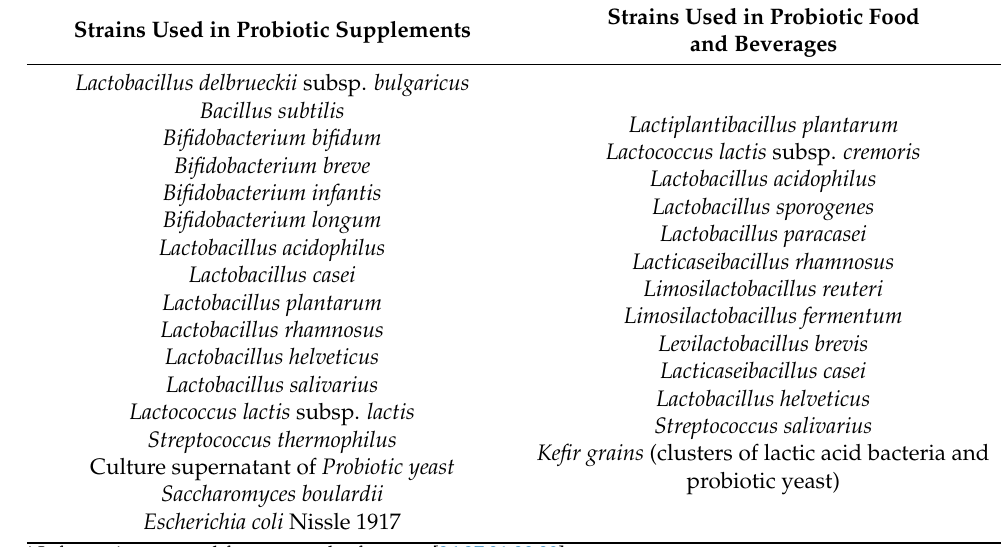
Table 1. Characterized probiotic strains with potential applications as biotherapeutic agents *. Strains Used in Probiotic Strains Used in Probiotic Supplements